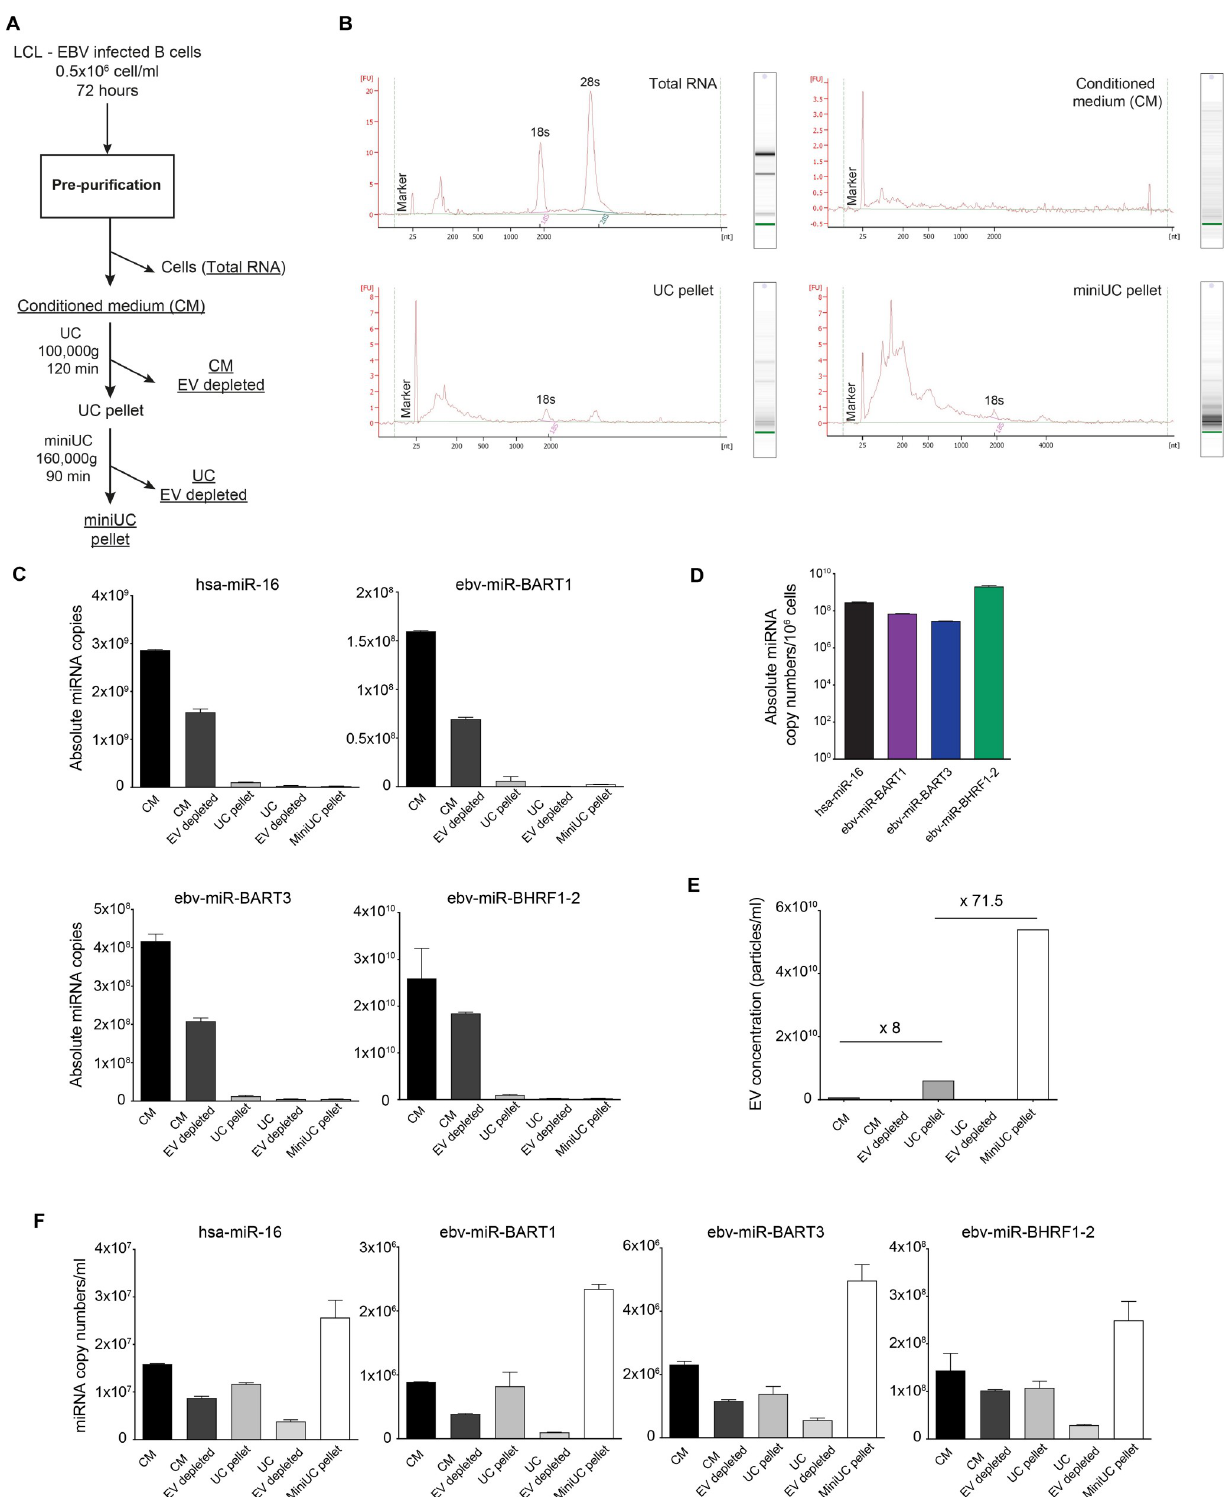
Fig 2. microRNAs quantitation during different steps of EV purification. (A) Schematic overview of EV sample collection and purification. After 72 h of LCL cell culture, we collected (i) the cell supernatant (‘conditioned medium’; 180 ml), (ii) the pellet after ultracentrifugation (‘UC pellet’; 9 ml), (iii) the supernatant after ultracentrifugation (‘conditioned medium EV depleted’ (180 ml), (iv) the pellet after the second ultracentrifugation step (‘miniUC